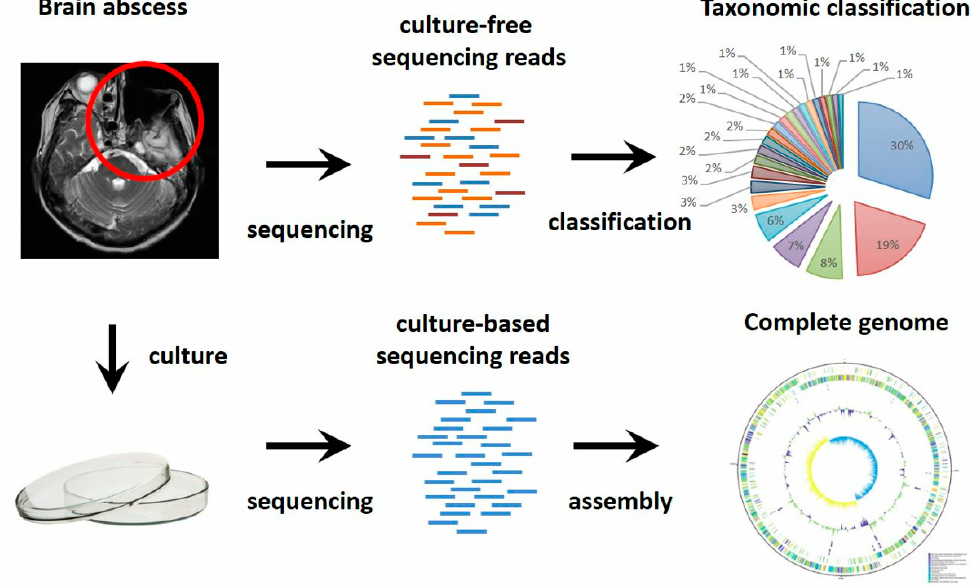
Figure 2. Experimental workflow of culture-based and culture-free sequencing. Brain abscess was first confirmed by MRI. The abscess sample was cultivated and followed by sequencing and